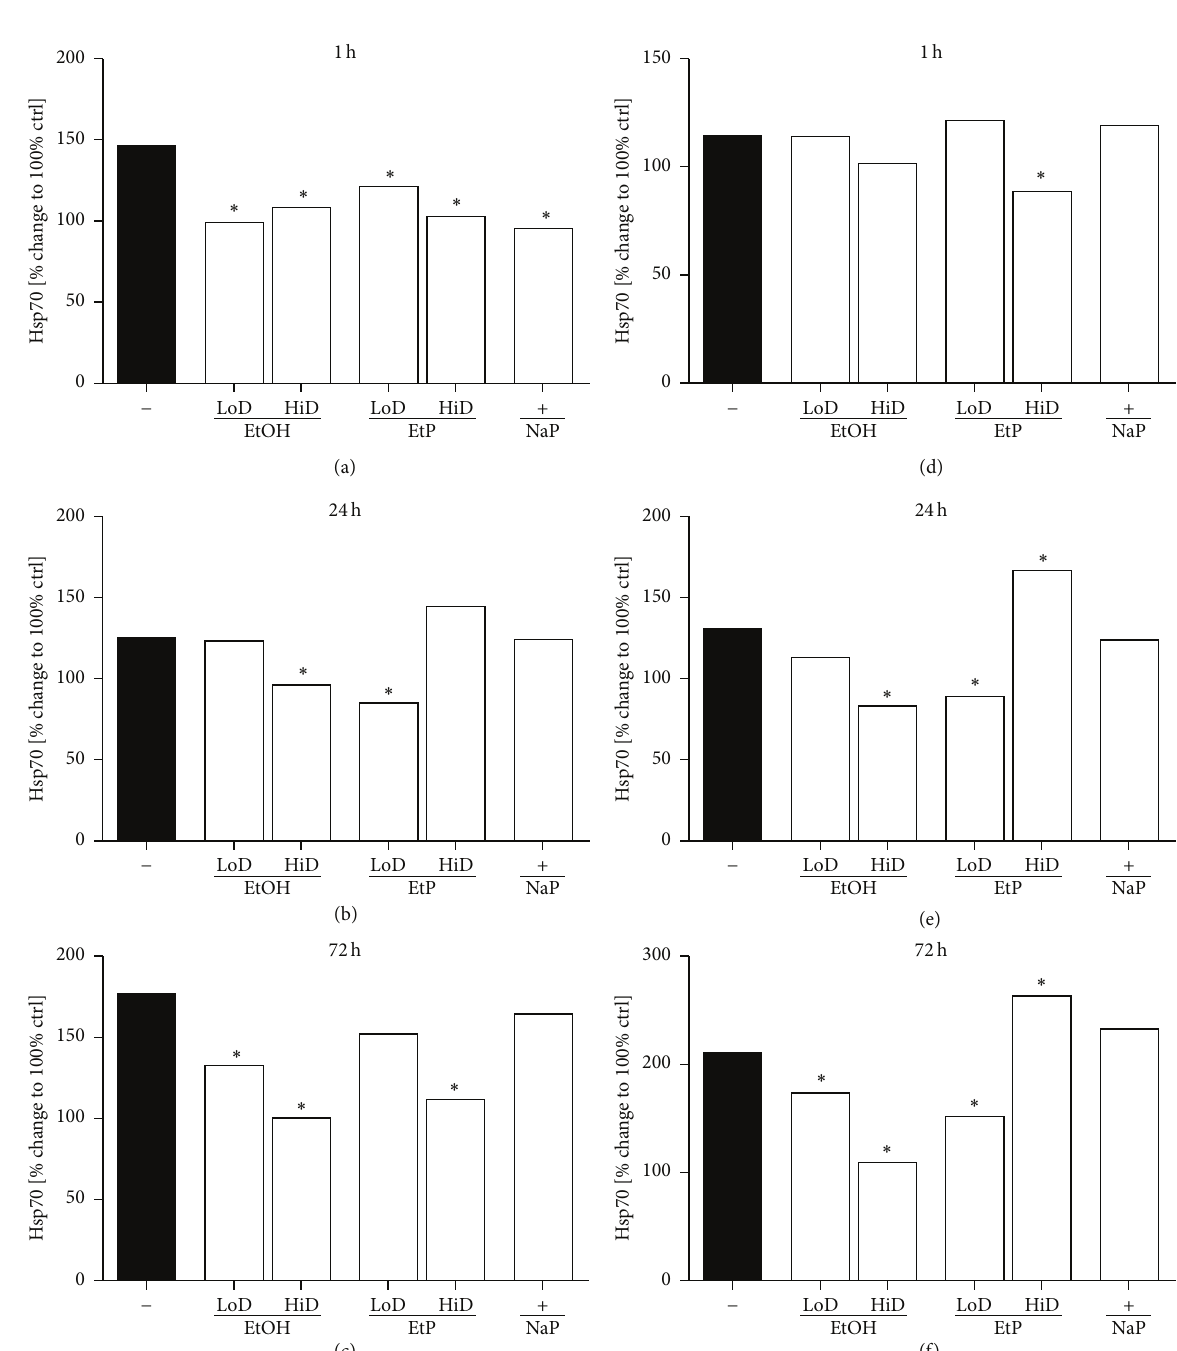
Figure 7: Effects of ethanol (EtOH), ethyl pyruvate (EtP), or sodium pyruvate (NaP) on heat-shock protein (hsp70) gene expression in lung epithelial cells A549 after IL-1beta ((a)–(c)) or lipopolysaccharide (LPS (d)–(f)) stimulation. Cells were treated with EtOH (low dose, LoD = 85 mM and high dose, HiD = 170 mM), EtP (LoD = 2.5 mM, HiD = 10mM), or NaP (10mM) for 1h ((a) and (d)), 24 h ((b) and (e)), or 72 h ((c) and (f)) and then stimulated with IL-1beta (1ng/mL) or LPS (1 𝜇 g/mL) for 24 h. After normalization to GAPDH expression, gene expression was measured as % change compared to hsp70 expression in cells stimulated with agonists only (control, ctrl, as 100%). ∗ 𝑃 < 0.05 versus untreated stimulated